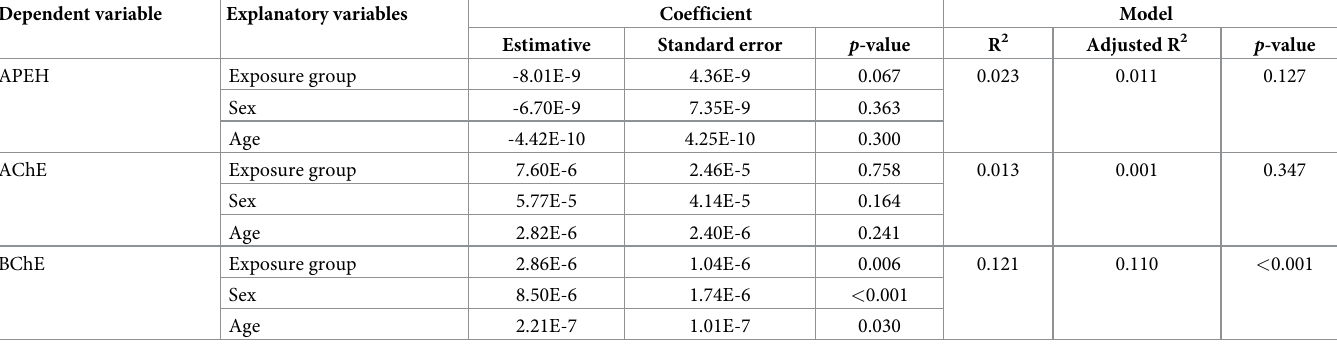
Table 2. Variables influencing enzyme biomarkers at the baseline measurement (pre-spraying